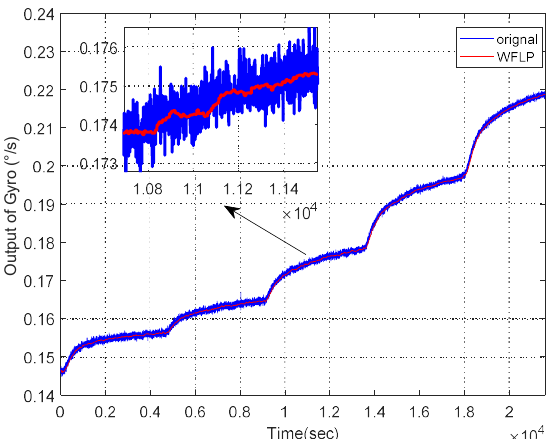
Figure 11. Original signal compared with WFLP.